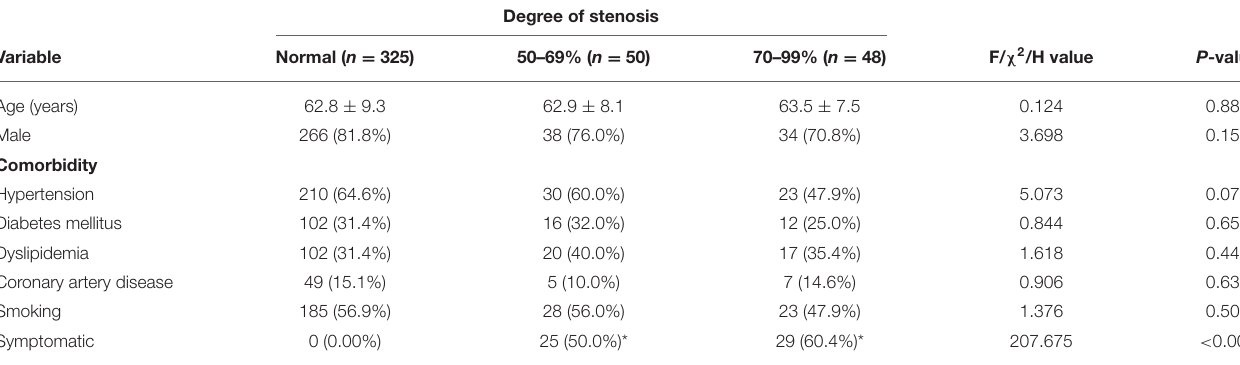
TABLE 1 | Demographic